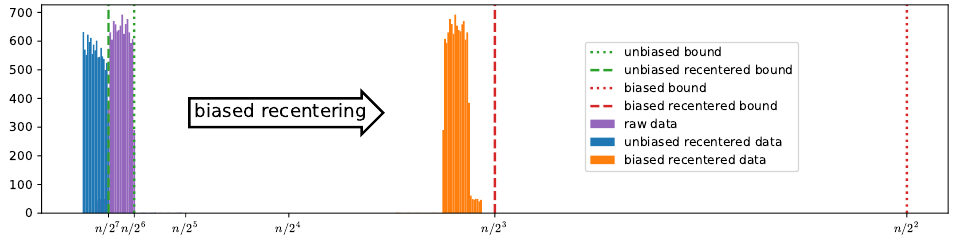
Figure 19: Distributions of the i = 50-th out of N = 5000 nonces, sorted by bit-length, with both the biased bound l = 2 and unbiased bound l = 6. The effect of i i biased recentering manifests as a shift of the raw data to the